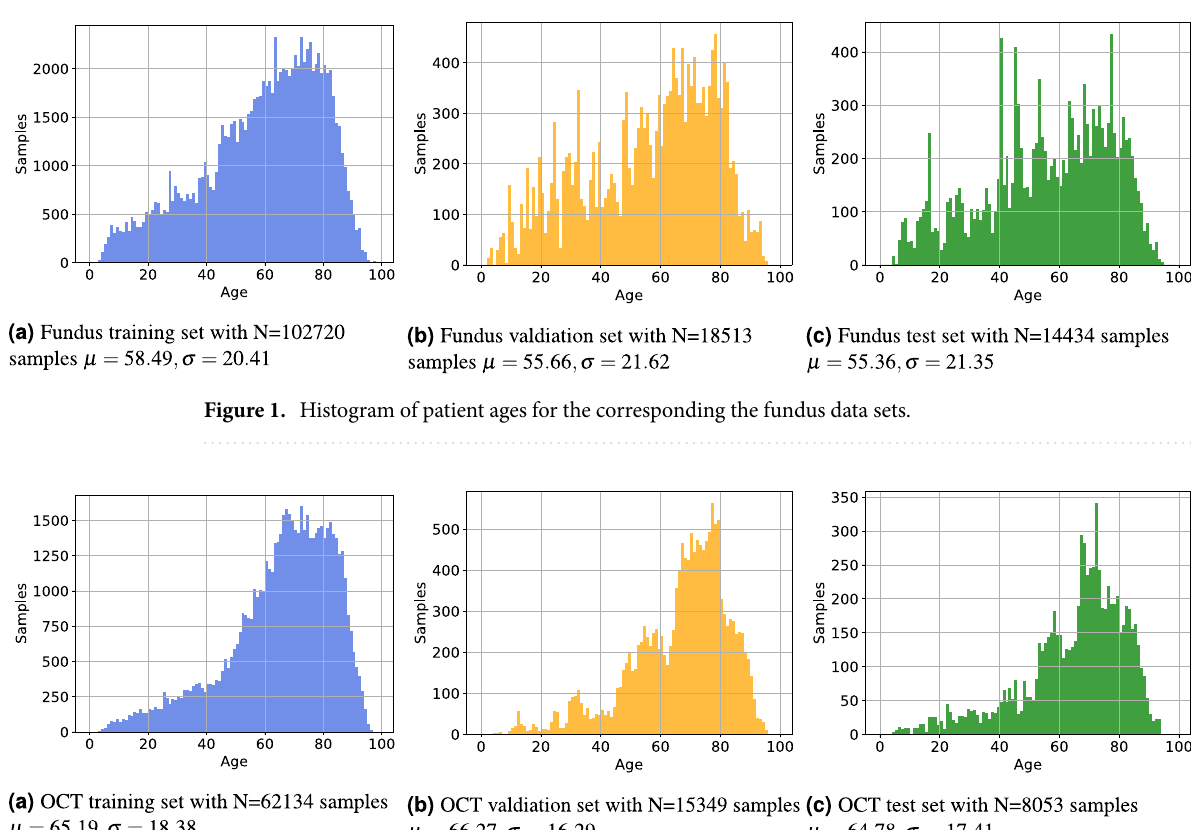
Figure 2. Histogram of patient ages for the corresponding the OCT data